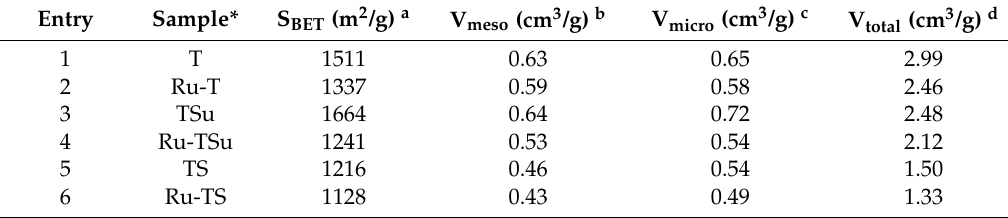
Table 1. Textural parameters determined from N 2 adsorption.